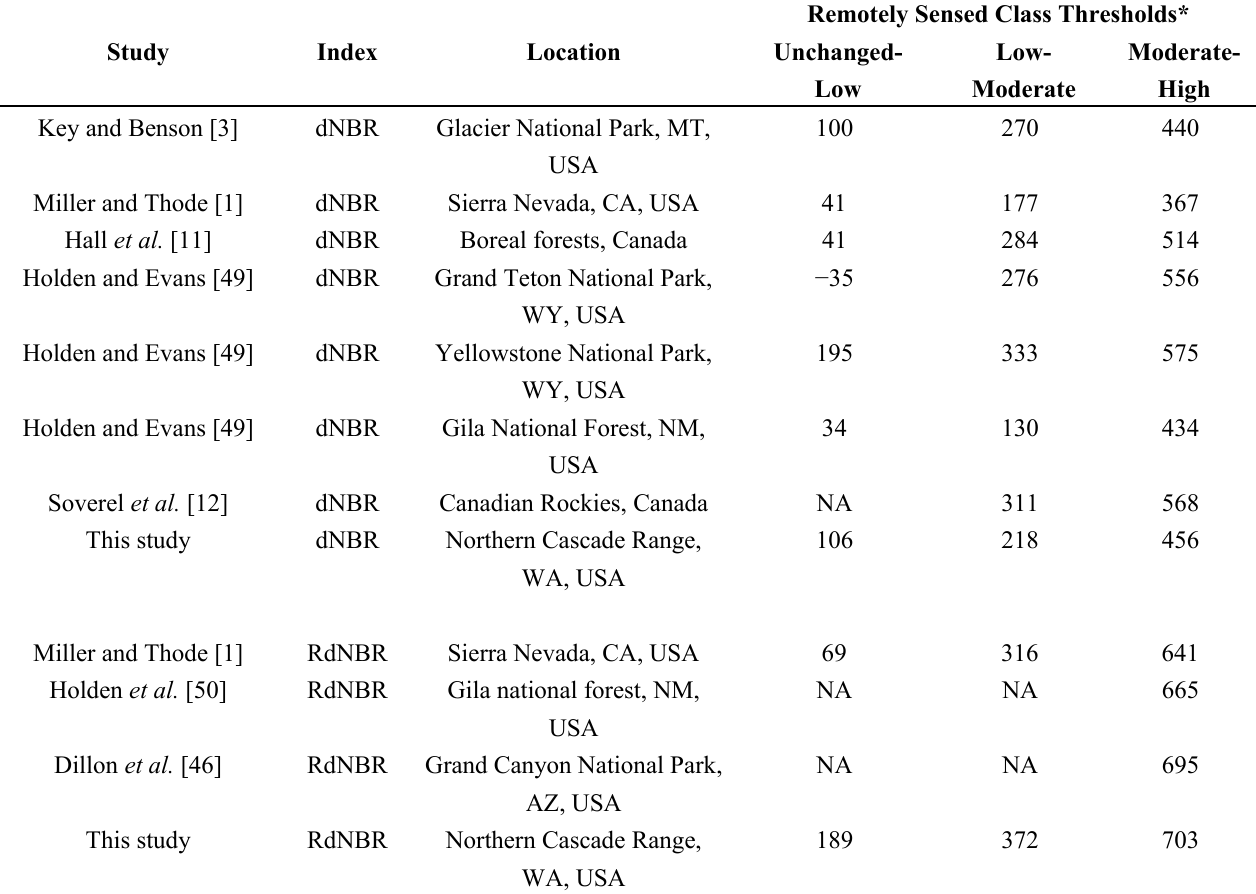
Table 13. Severity class thresholds for the northern Cascade Range compared to those of other studies in conifer forests of North America that used CBI to classify dNBR and RdNBR using data from one year after